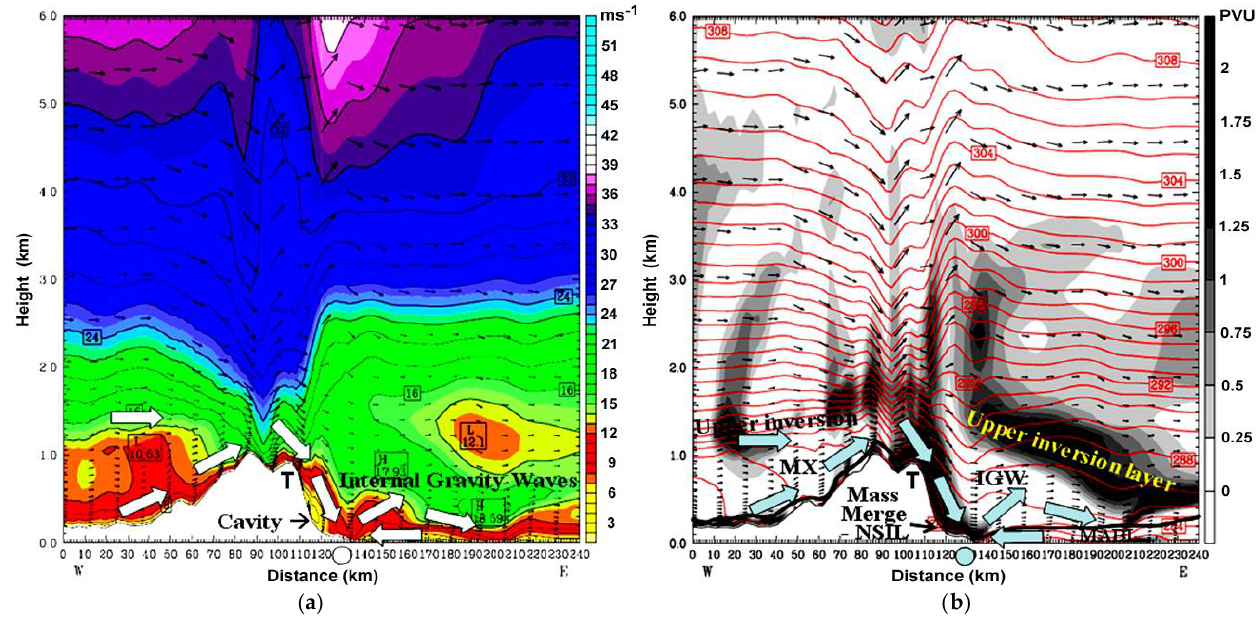
Figure 17. Vertical profile of ( a ) horizontal wind (m/s) and ( b ) potential temperature (k) and wind speed (m/s) in the third domain of WRF model at ( a ) 20:00 LST, 30 March 2004. NSIL, Tick line, MX, T, IGW and MABL and a small circle denote nocturnal surface inversion layer, its top, mixed layer, Mt. Taegulyang, internal gravity waves, marine atmospheric boundary layer and Gangneung city.